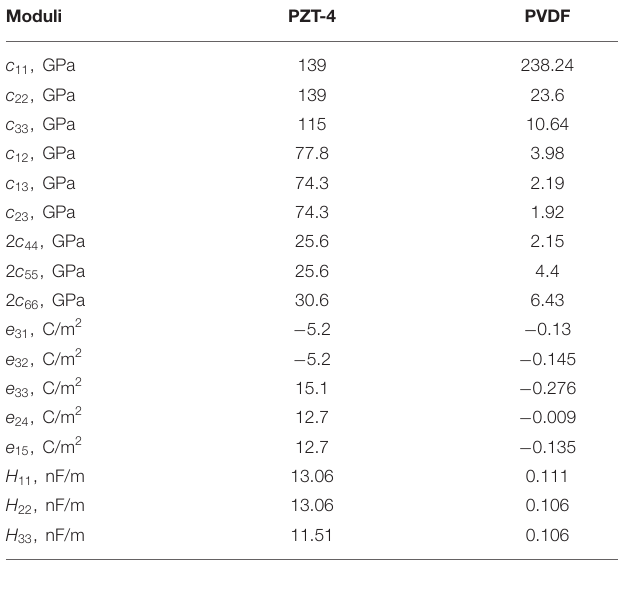
TABLE 1 | Piezoelectric material properties for PZT-4 and PVDF, Fernades and Pouget